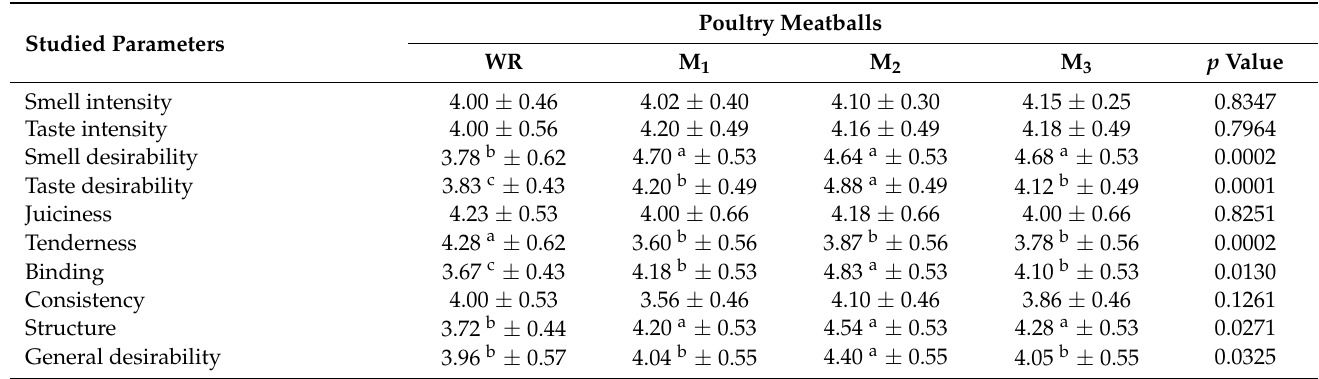
Table 5. Effect of adding a mixture of linseed, amaranth and hemp seeds on the sensory traits of poultry meatballs